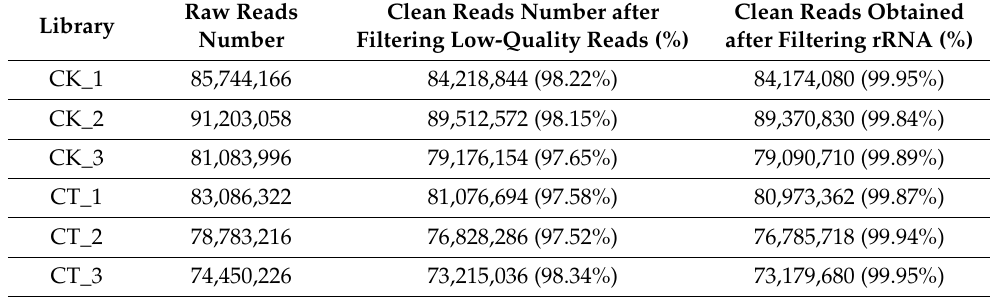
Table 1. Summary of the sequencing reads.